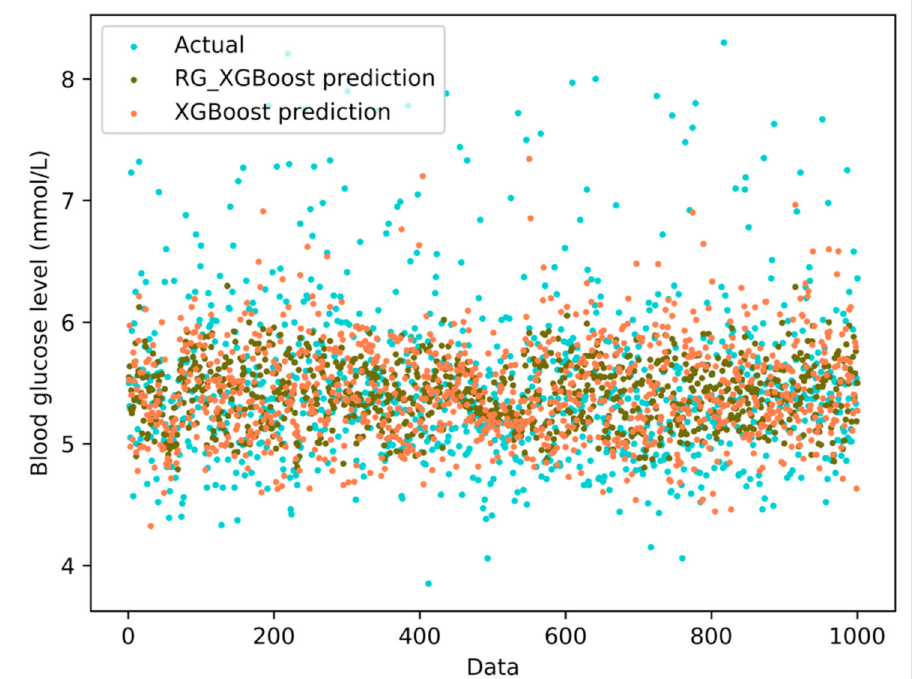
Figure 13. The scatter plot diagram of the actual and predicted blood glucose (fasting/pre-prandial) levels by the RG_XGBoost and XGBoost